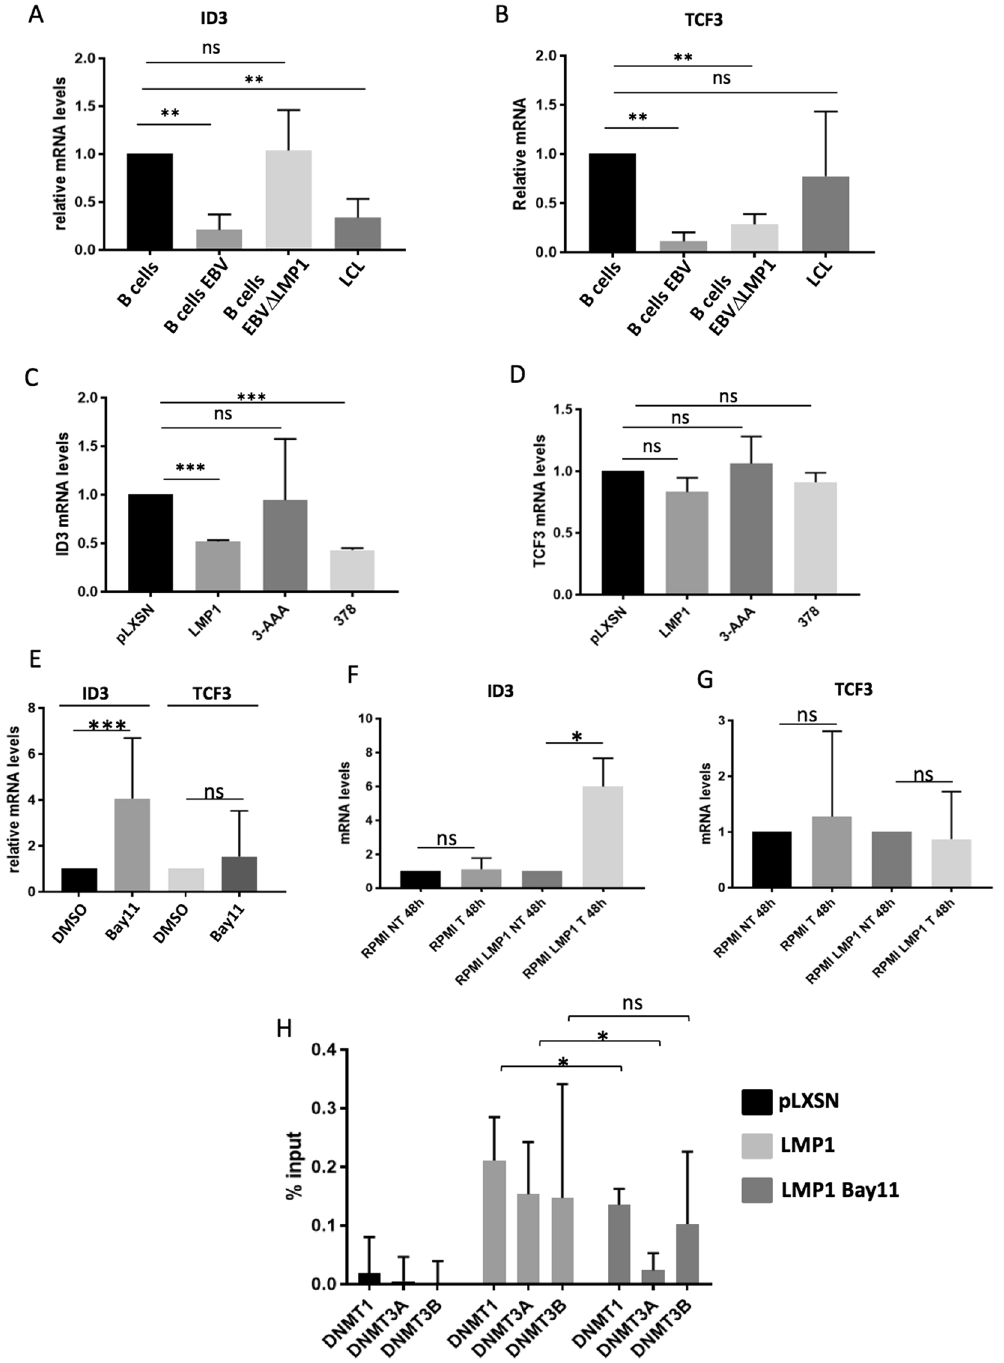
Figure 6. LMP1-mediated downregulation of ID3. ( A and B ) B cells from two donors were infected with WT or Δ LMP1 EBV and collected 48 h post-infection. Retro-transcribed RNA samples were analyzed by qPCR for the levels of ID3 ( A ) or TCF3 ( B ) ( ** p value < 0.01). ( C and D ) RPMI cells were stably transduced with pLXSN (pLXSN) or with pLXSN-LMP1 WT (LMP1) or mutated (3-AAA and 378). cDNA samples were interrogated by qPCR for the levels of ID3 ( C ) and TCF3 ( D ) ( *** p value < 0.001). ( E ) RPMI-LMP1 cells were treated for 2 h with Bay11 (10 μ M). cDNA samples were analyzed by qPCR for the mRNA levels of ID3 and TCF3 ( *** p value < 0.001). ( F and G ) RPMI or RPMI-LMP1 cells were cultured in presence of Aza (T) or in DMSO (NT) and the mRNA levels of ID3 and TCF3 were analyzed by qPCR ( *** p value < 0.001). ( H ) RPMI pLXSN and RPMI-LMP1 cells, the latter, treated or not with Bay11 (10 μ M) for 2 h, were used to perform ChIP with indicated antibodies. The eluted DNA was analyzed by qPCR with primers designed in the promoters of ID3 ( * p value <